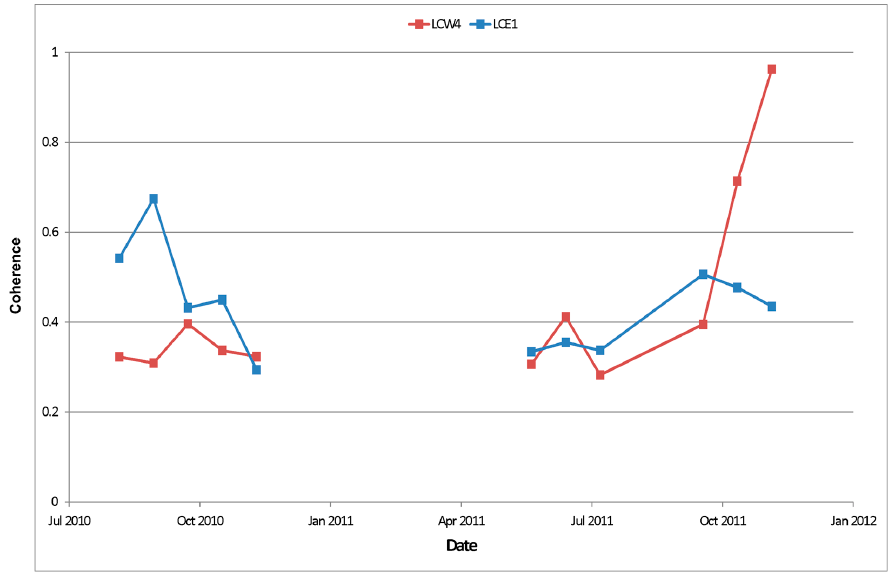
Figure 6. Wetlands Lake Clear West-4 and Lake Clear East-1 coherence profile for 2010/2011 showing abrupt changes in coherence due to sudden changes in water level.